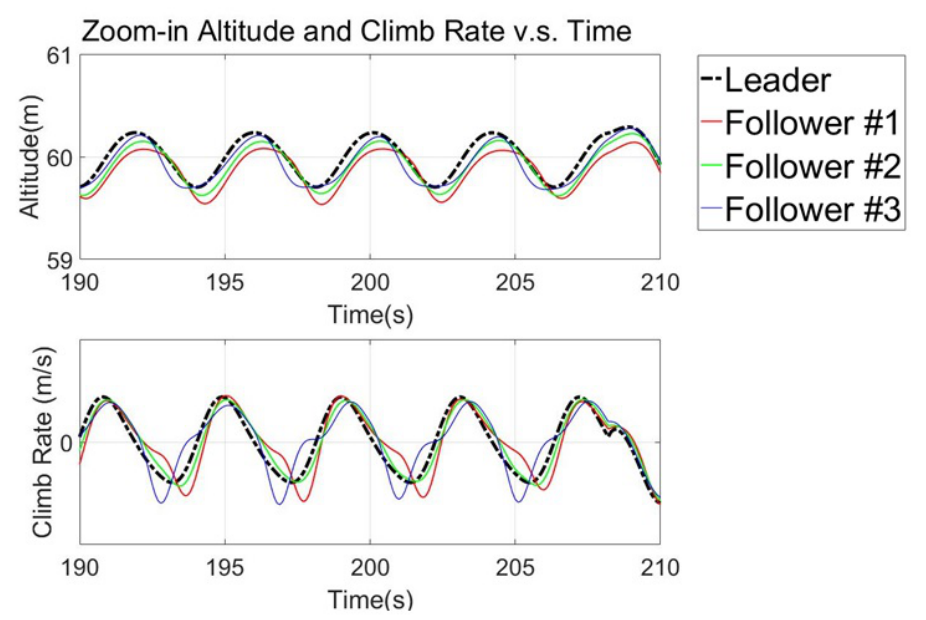
Figure 19. Zoom-in of the responses of altitude and climb rate during 190 to 210 seconds.